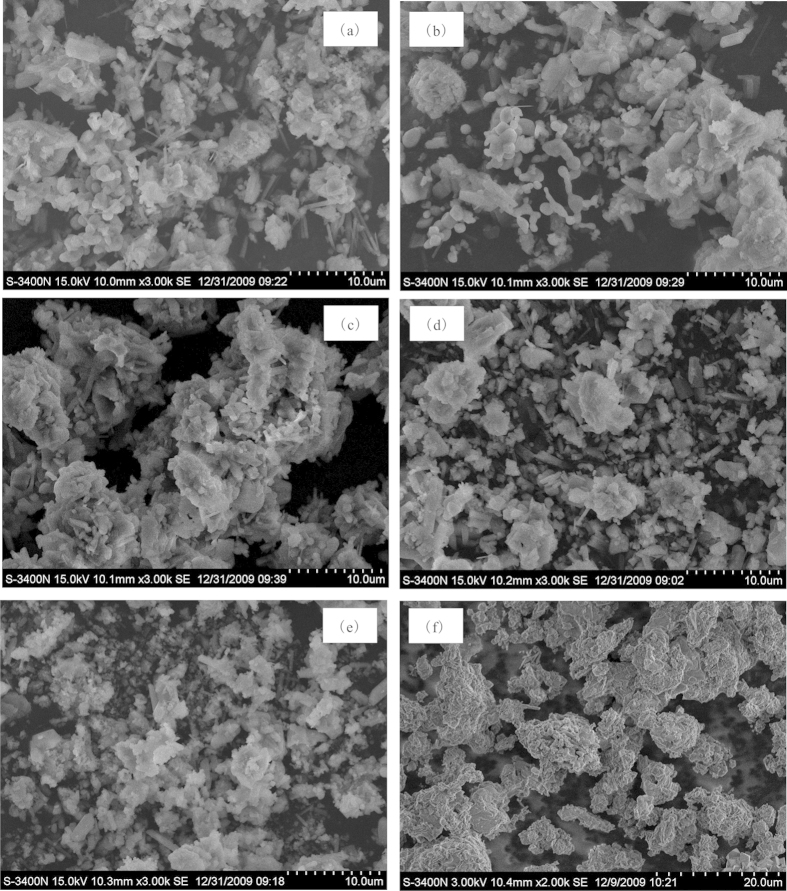
SEM photographs of fly ash with (a) 0% chlorination agent (b) 10% CaCl2 (c) 10% MgCl2 (d) 10% NaCl (e) 10% FeCl3 and (f) 10% AlCl3 after incineration at 1000 °C for 60 min.